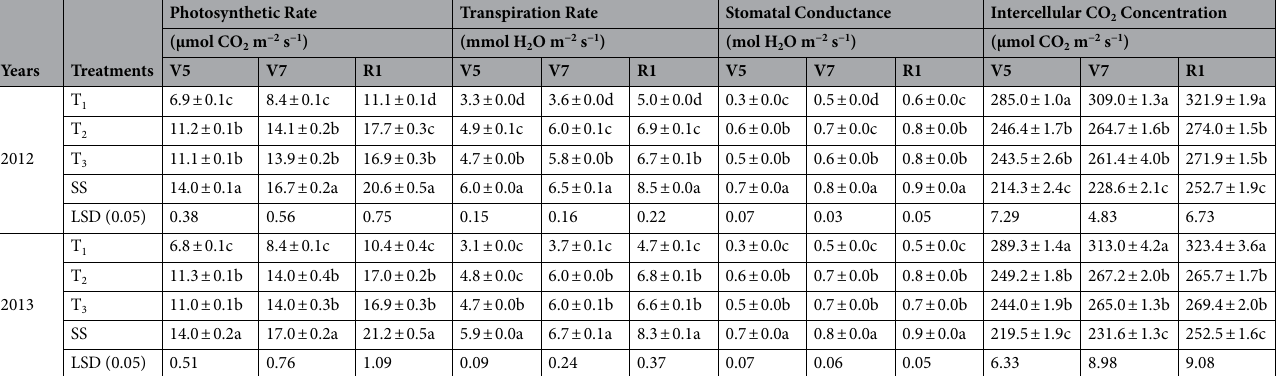
Table 4. Effect of different strip-width treatments on photosynthetic characteristics of soybean at fifth trifoliate stage (V5), seventh trifoliate stage (V7), and flower initiation stage (R1) in cropping seasons from 2012 to 2013. Treatment codes represent narrow-strips (T 1 , 180 cm); medium-strips (T 2 , 200 cm); and wide- strips (T 3 , 220 cm) in maize/soybean relay intercropping system. SS is the sole cropping system of soybean. Means are averages over three replicates ± standard error of the mean. Means that do not share the same letters in a column differ significantly at p ≤ 0.05 using least significant differences, calculated separately for each